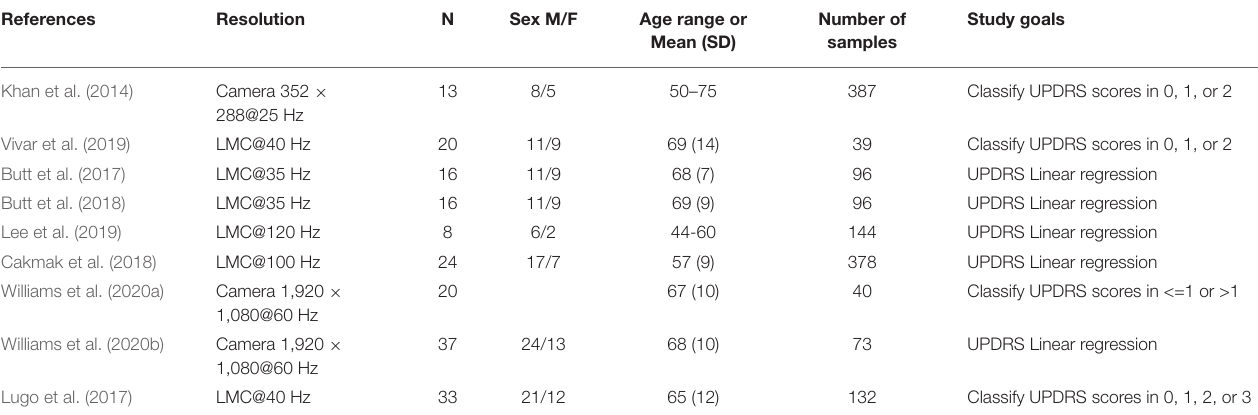
TABLE 2 | Study cohorts and goals.